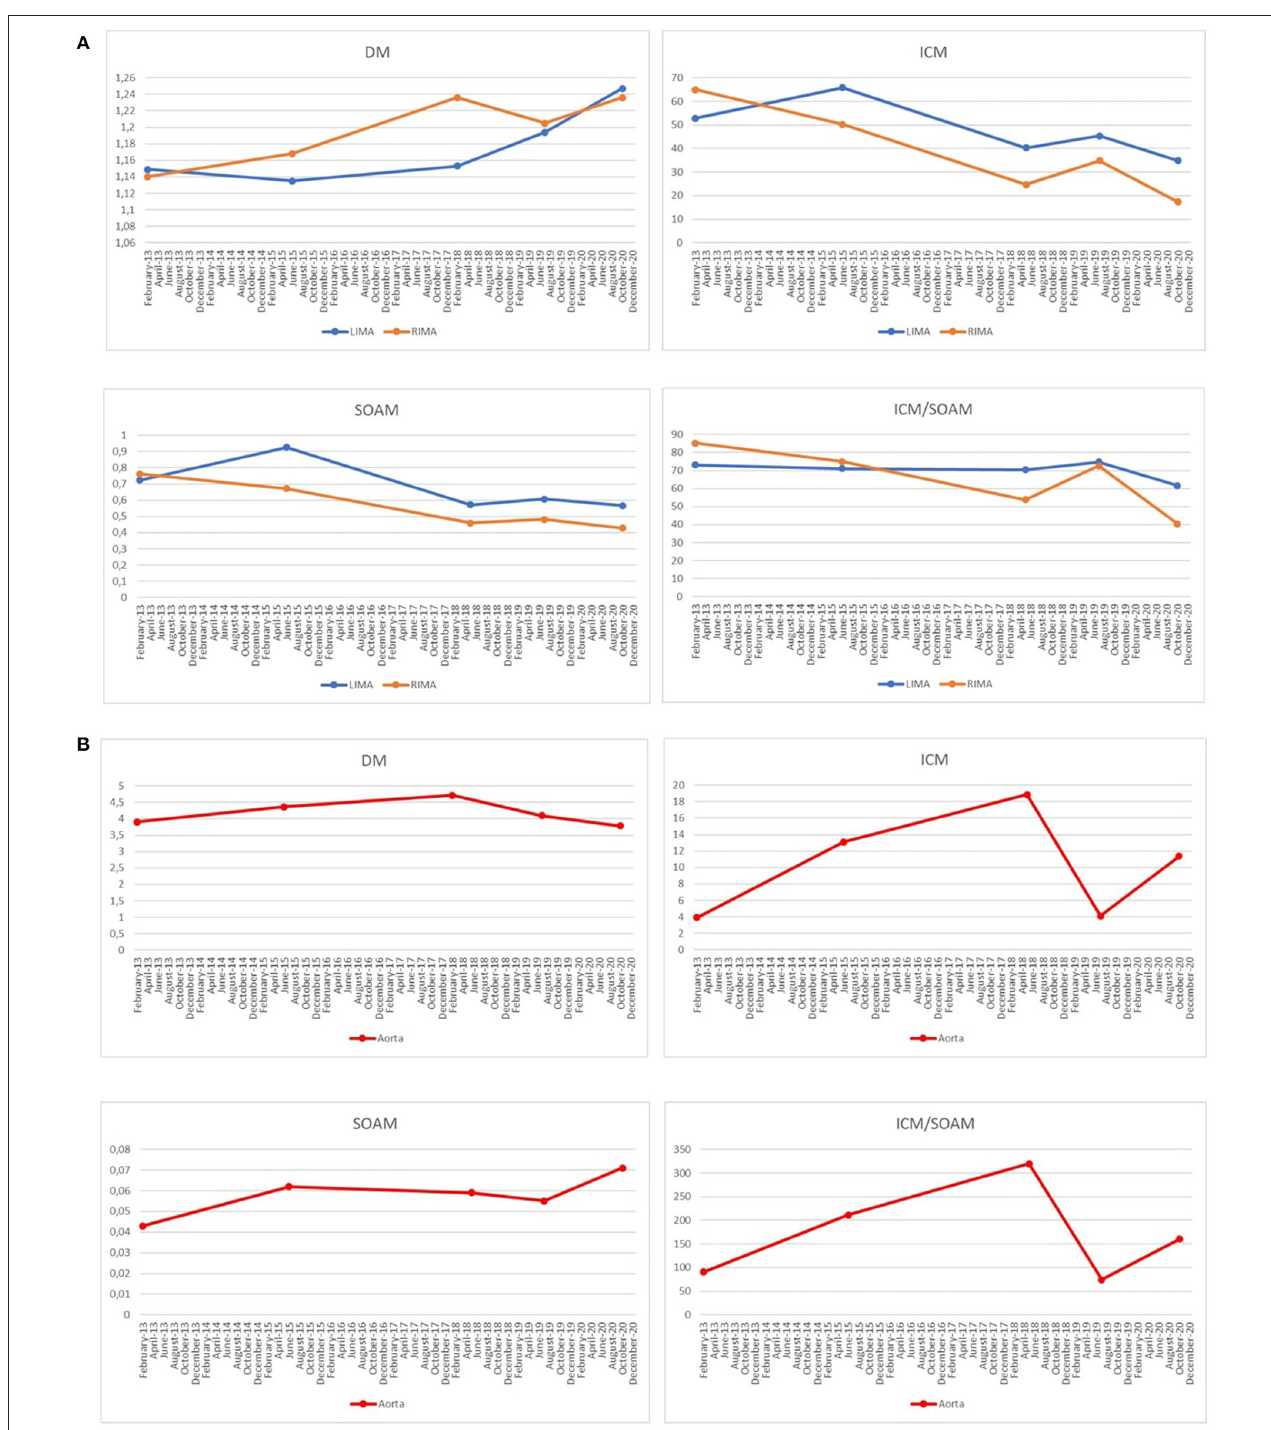
FIGURE 3 | (A) A progression of the tortuosity of the right internal mammary artery (RIMA) and the left internal mammary artery (LIMA) demonstrated by an increase in the Distance Metric (DM) value can be observed. The other parameters used to assess the tortuosity of a vessel are Inflection count metric (ICM), which is sensitive to higher amplitude structures, Sum of angles metric (SOAM), which is increased in case of higher frequency structures and ICM/SOAM. In this case, they are less conclusive as they all show a decreasing tendency. (B) The thoracic aorta shows an increasing tortuosity with increasing amplitude and frequency of the curves demonstrated by the overall rise of the ICM, SOAM, and ICM/SOAM parameters.